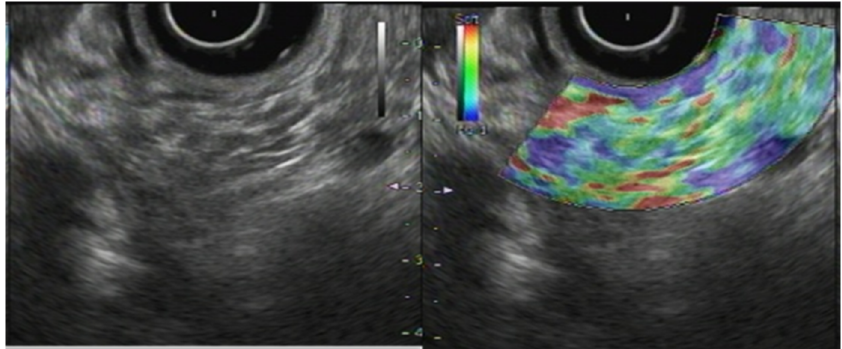
Figure 2. Endosonography (EUS) elastography in chronic